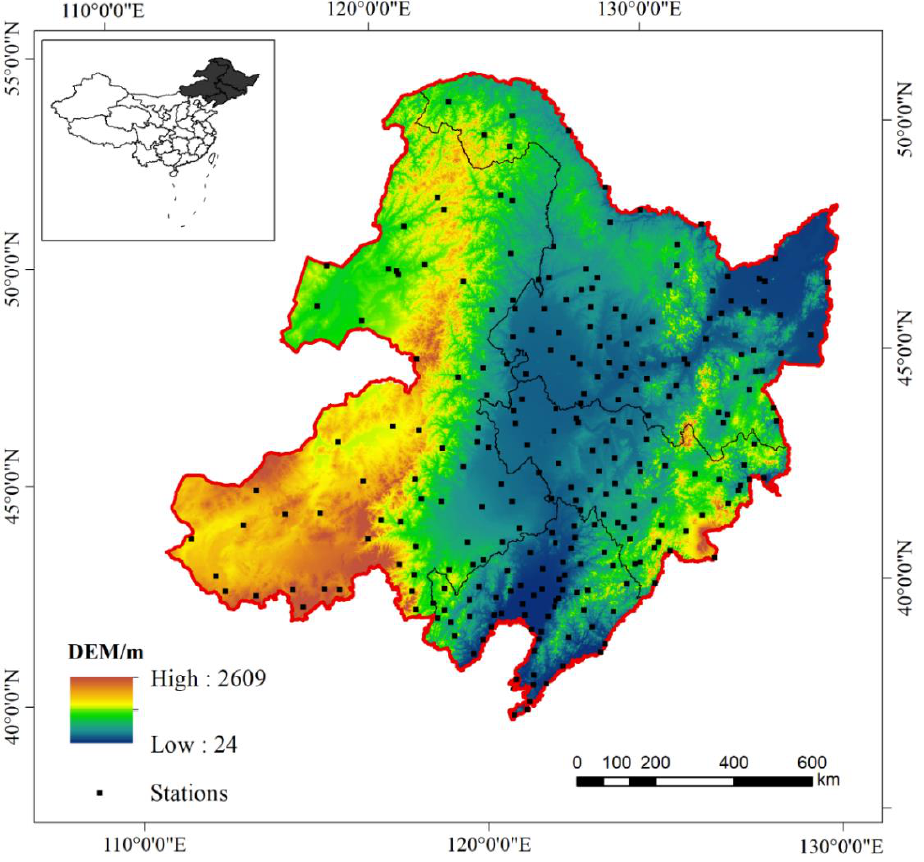
Figure 1. The location and topography of the study area and 262 ground meteorological sites in the study area where data were collected.